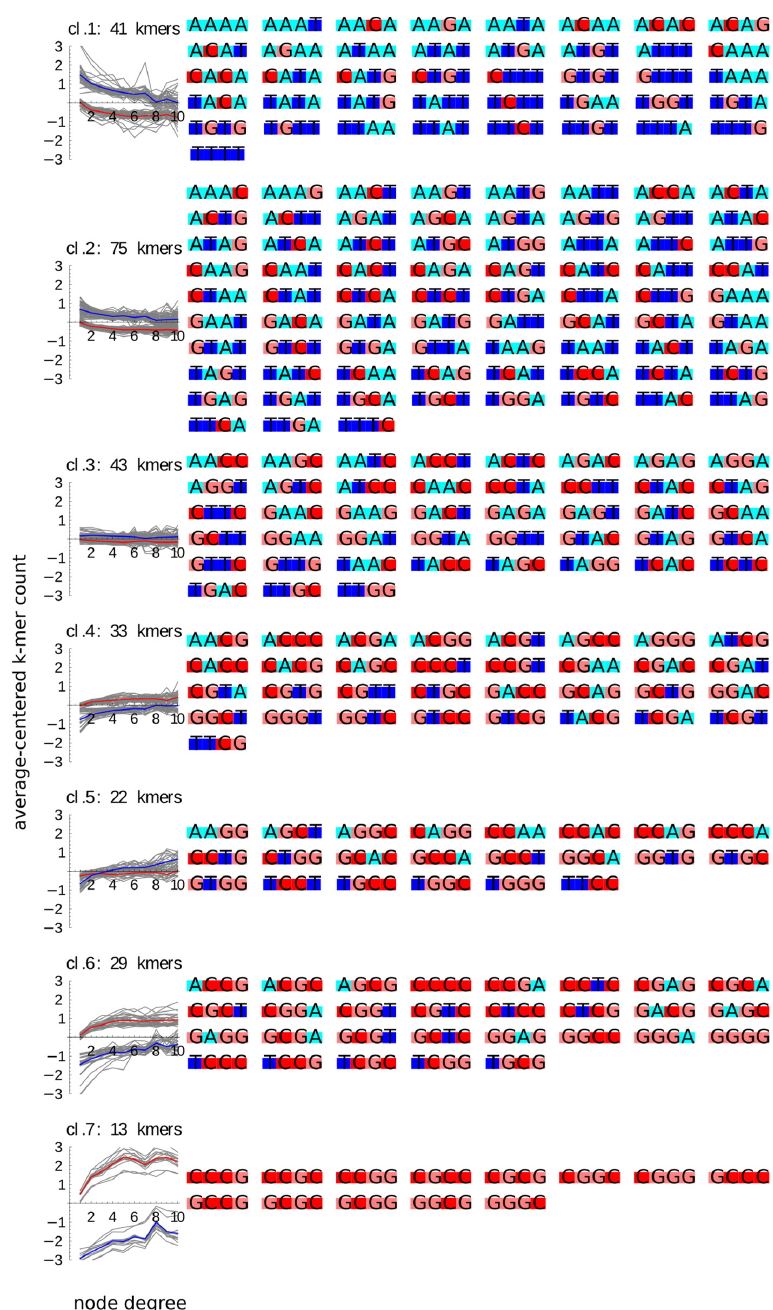
Figure 3. Base composition of the k-mer clusters (same as in Figure 2). The sequences of k-mers in each cluster are plotted alongside the profiles of this cluster, with every nucleotide marked by a different character background color: A-cyan, T-blue, G-pink,